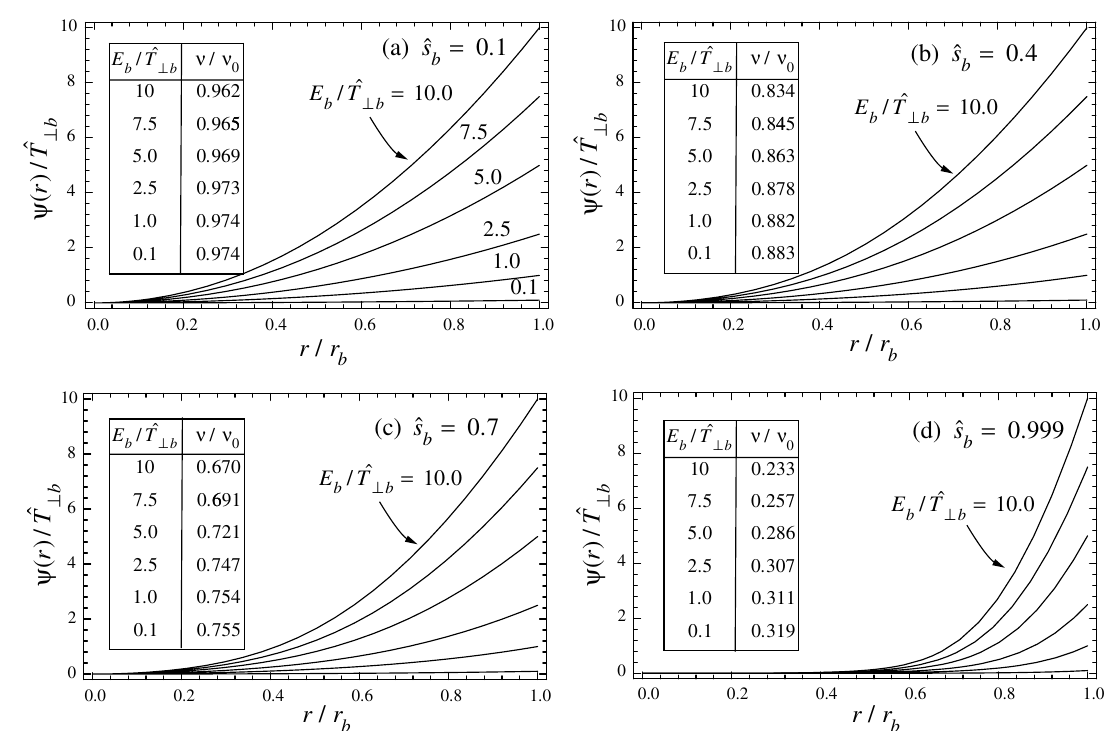
(cid:4) 0 : 1 , (b) ^ ss (cid:4) 0 : 4 , (c) ^ ss (cid:4) 0 : 7 , and b b b